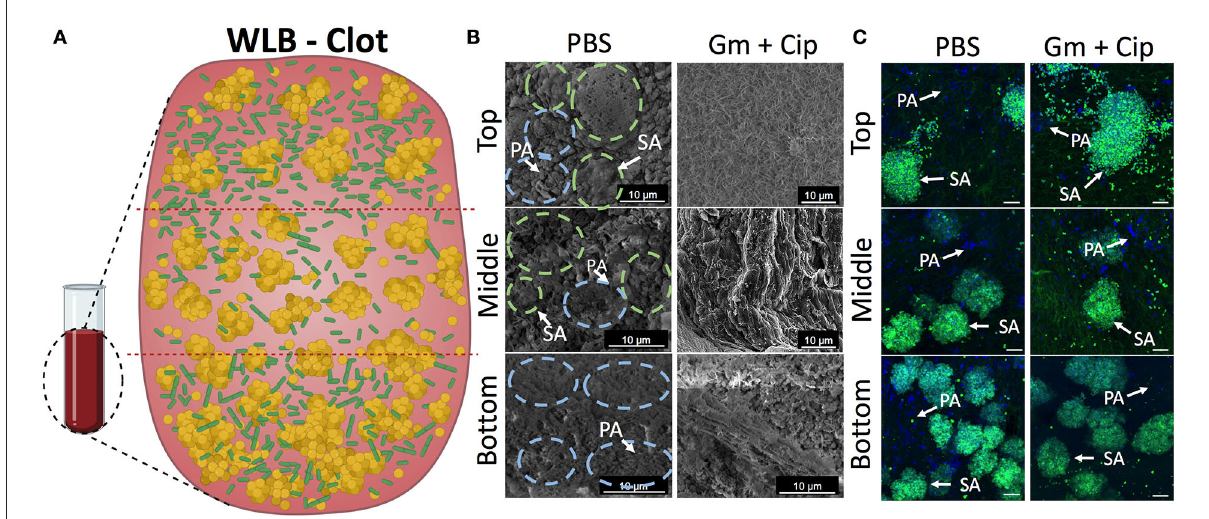
FIGURE5 Spatial bacterial distribution in the in vitro wound biofilm system before and after antibiotic treatment. Analysis of the transversal parts of the WLB (top, middle, and bottom) (A) using FE-SEM (B) and CSLM (C) . In the FE-SEM images, blue and green dashed circles surround P. aeruginosa and S. aureus bacterial aggregates, respectively. In CSLM images, P. aeruginosa PAO1 (PA) is dyed with DAPI (blue), and S. aureus SA31 (SA) is stained with WGA (green). (A) Scheme of the three-dimensional WLB colocalization model proposed. (B) FE-SEM and (C) CSLM representative images of the transversal parts of P- aeruginosa – S. aureus two-species biofilm in the clots under the effect of a 16-h treatment of ciprofloxacin (Cip) and gentamicin (Gm) and left untreated (PBS). In each region of the clot (top, middle, and bottom), two biological replicates were used, and at least five technical replicates per sample were taken. The scale bar corresponds to 10 µ